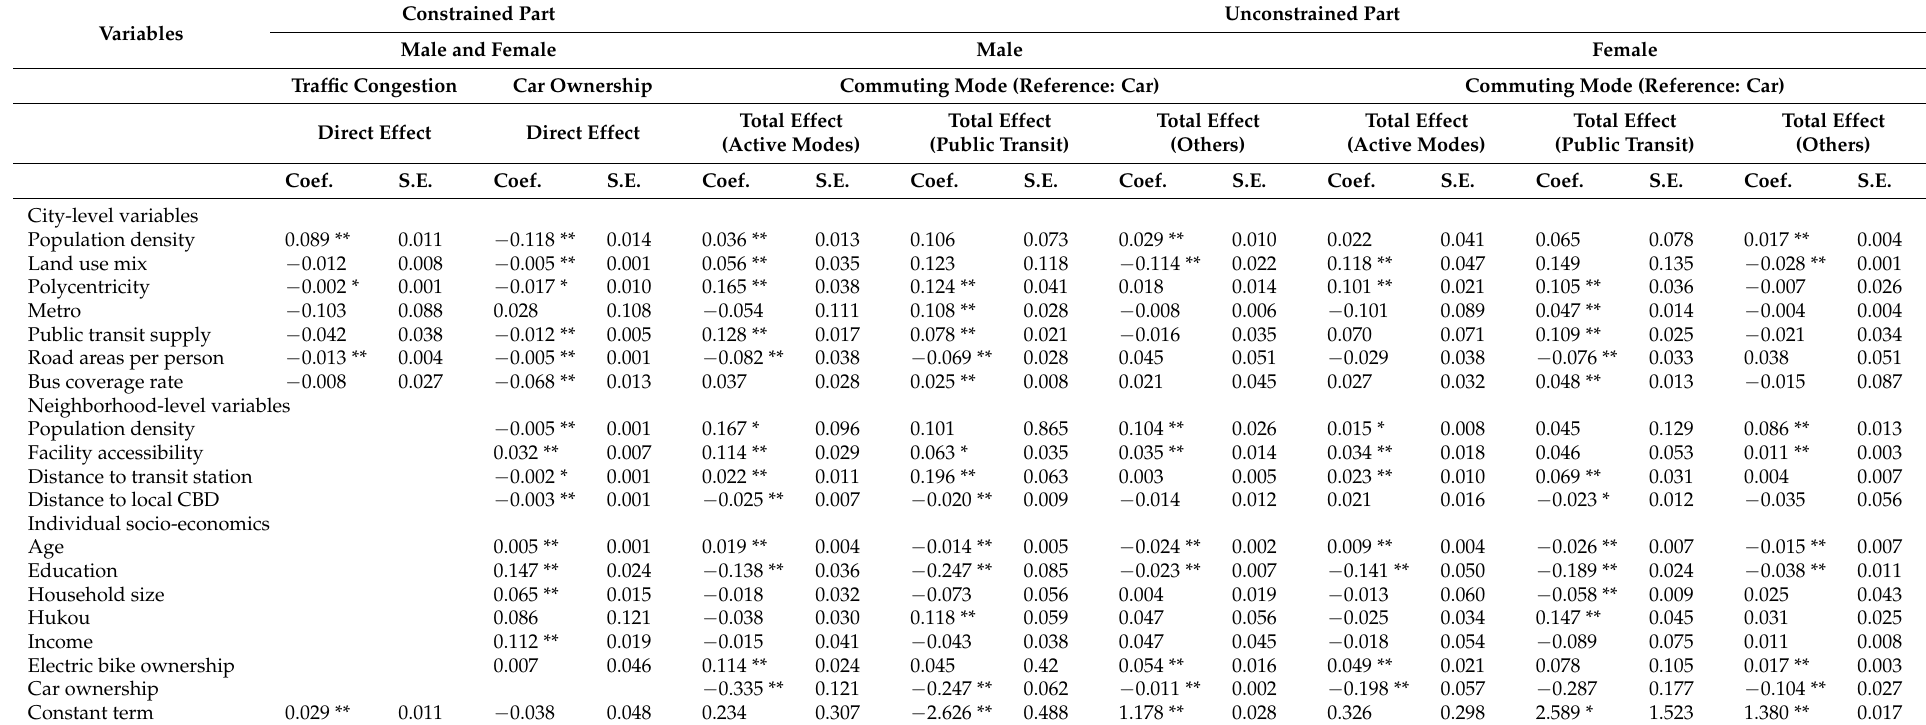
Table 5. Impact of multilevel BE on traffic congestion, car ownership, and commuting